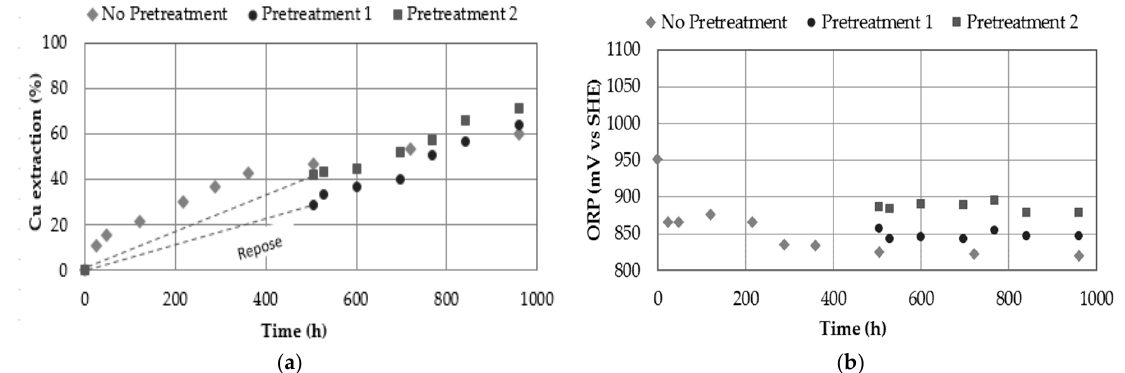
Figure 13. a) Copper extraction (%) versus time (h) at different pre-treatment. b) Redox potential 351 Figure 13. ( a ) Copper extraction (%) vs. time (h) at di ff erent pre-treatment. ( b ) Redox potential (mV) (mV) versus time (h) at different pre-treatment. Experimental conditions: [NaNO 3 ] = [H 2 SO 4 ] = 0.7 352 vs. time (h) at di ff erent pre-treatment. Experimental conditions: [NaNO 3 ] = [H 2 SO 4 ] = 0.7 M, 25 ◦ C, M, 25 °C, seawater as dissolvent and sample A. 353 seawater as dissolvent and sample